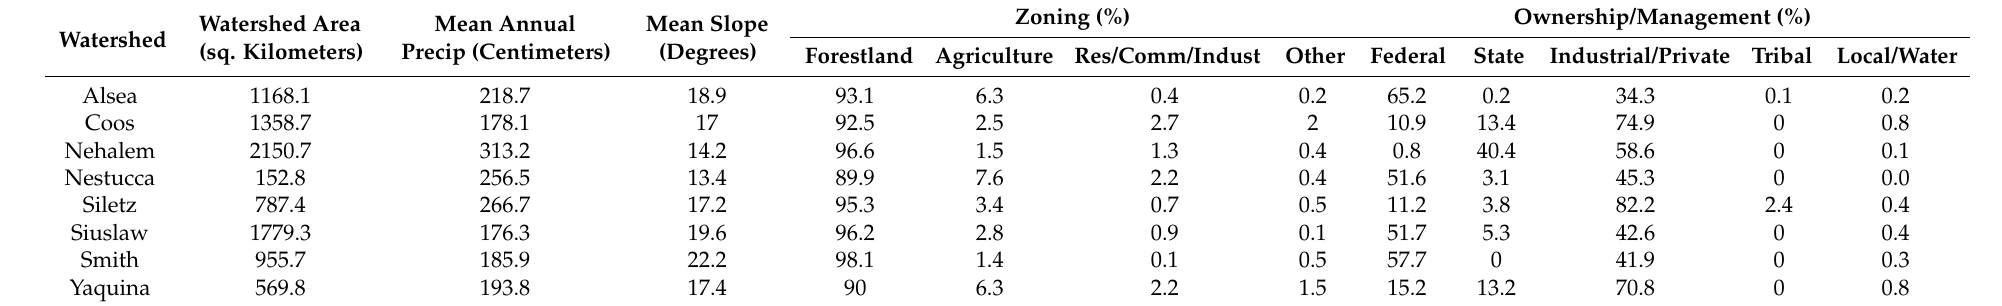
Table 1. Key attributes, zoning, and ownership/management characteristics of the forested watershed basins along the Oregon Coast Range. Abbreviations: Res/Comm/Indust = zoned for residential, commercial, and industrial